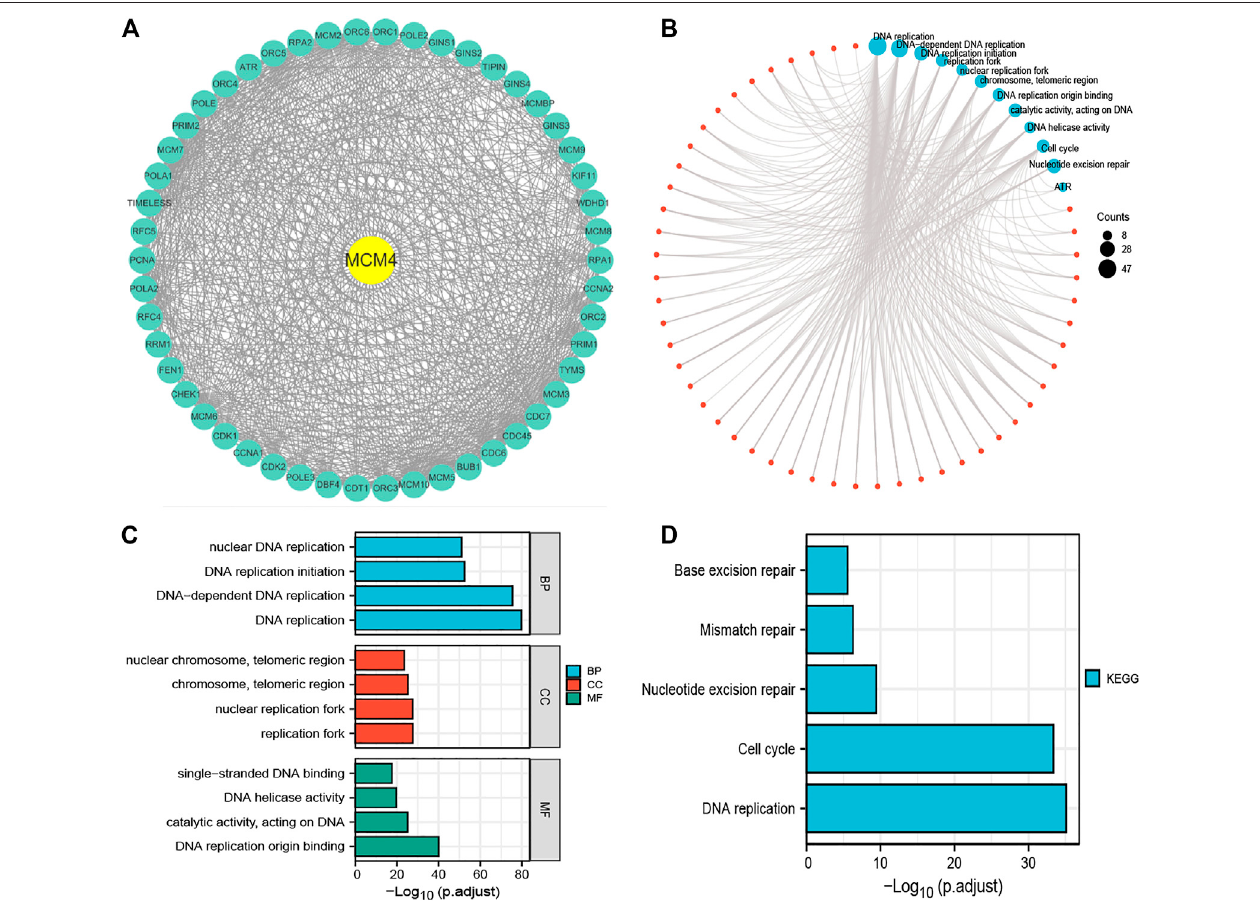
FIGURE 3 | Functional enrichment analysis of 50 targeted binding proteins of MCM4. (A) PPI network; (B) Visual network of GO and KEGG analyses; (C) GO enrichment analysis with BP, CC, and MF; (D) KEGG pathway analysis. PPI, protein-protein interaction; GO, gene ontology; KEGG, kyoto encyclopedia of genes and genome; BP, biological process; CC, cellular composition; MF, molecular